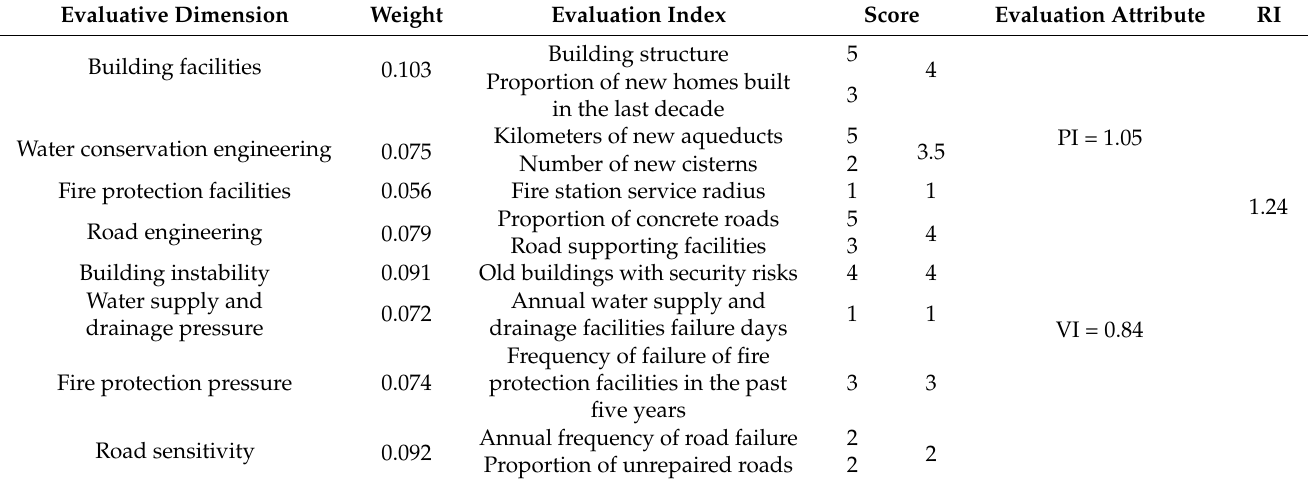
Table 4. Assessment results of engineering resilience in Fanhua